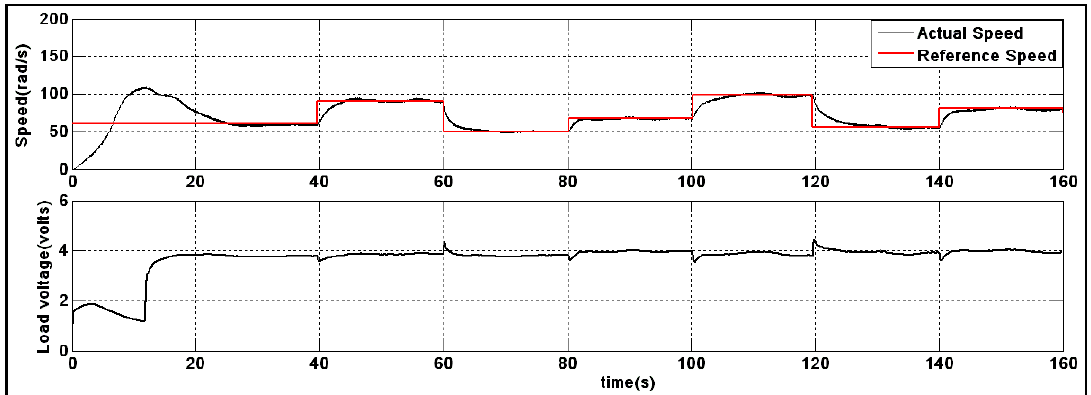
Figure 7. Speed tracking and load voltage under the SMC system.